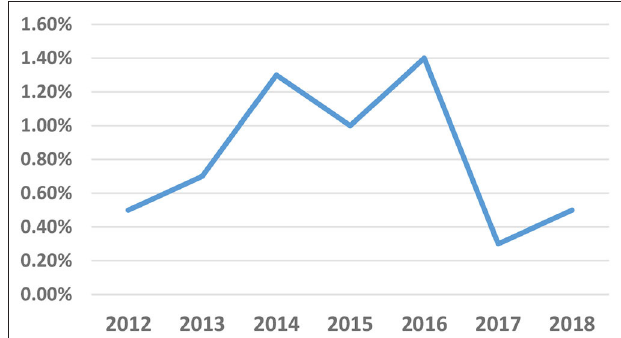
FIGURE 1 | Growth of non-fossil energy proportion in 2012–2018 (China Electric Power Planning and Engineering Institute, 2013, 2014, 2015,